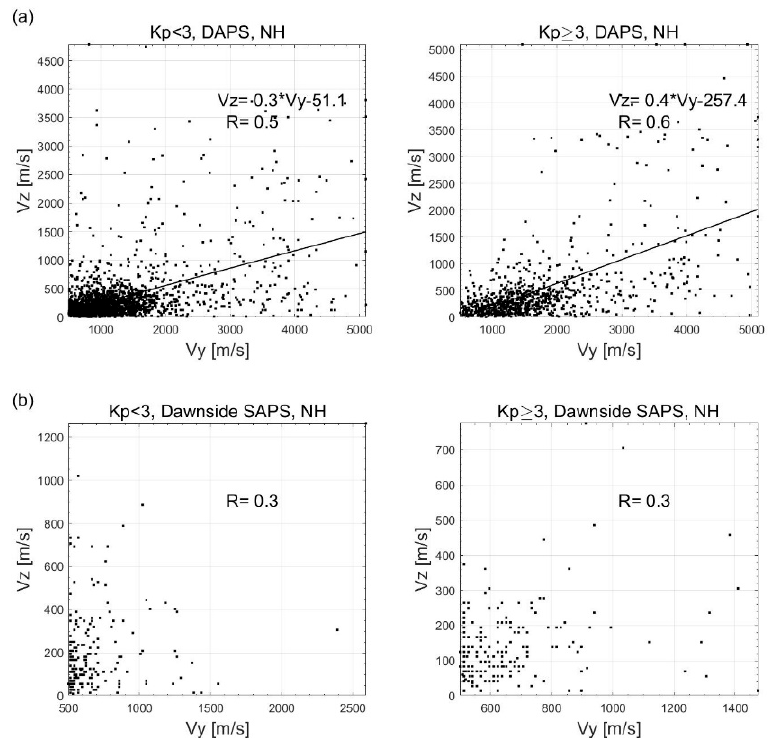
Figure 7. Correlation of DAPS ( a ) and SAPS ( b ) velocity with the upward velocity in the Northern Hemisphere under different geomagnetic activity levels. The correlation coefficient R (DAPS and SAPS), linear fitting line and fitting function (DAPS) are also shown.